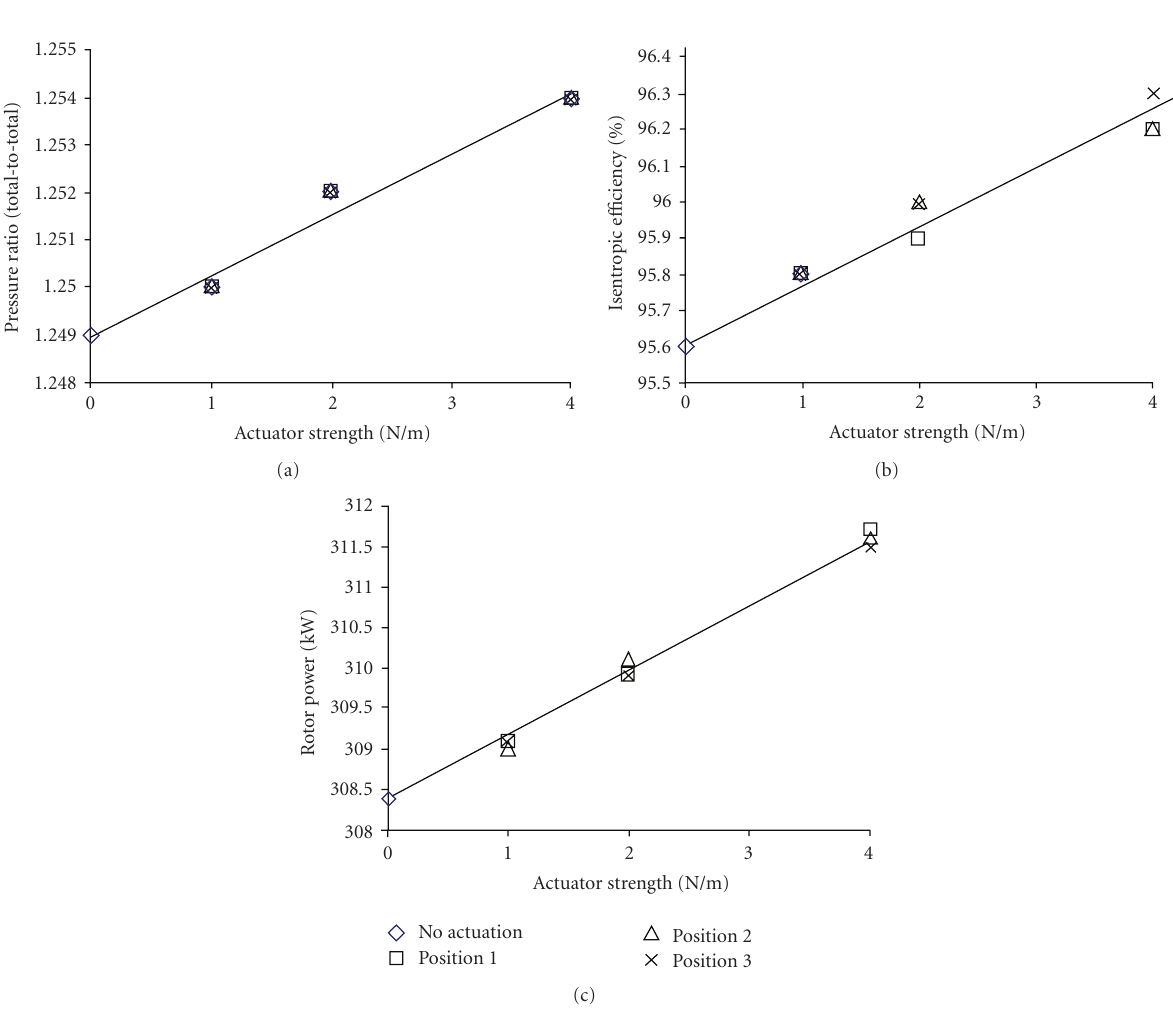
as e ff ective as a duty cycle of 50% to suppress boundary layer separation on a turbine blade.